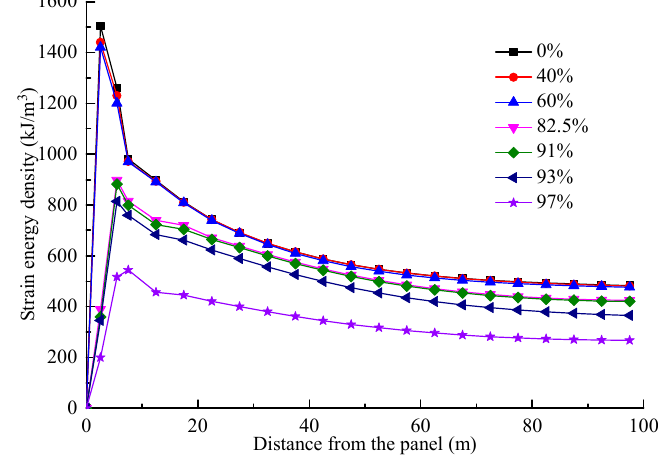
Figure 11. Comparative analysis of strain energy for different roof-controlled backfill